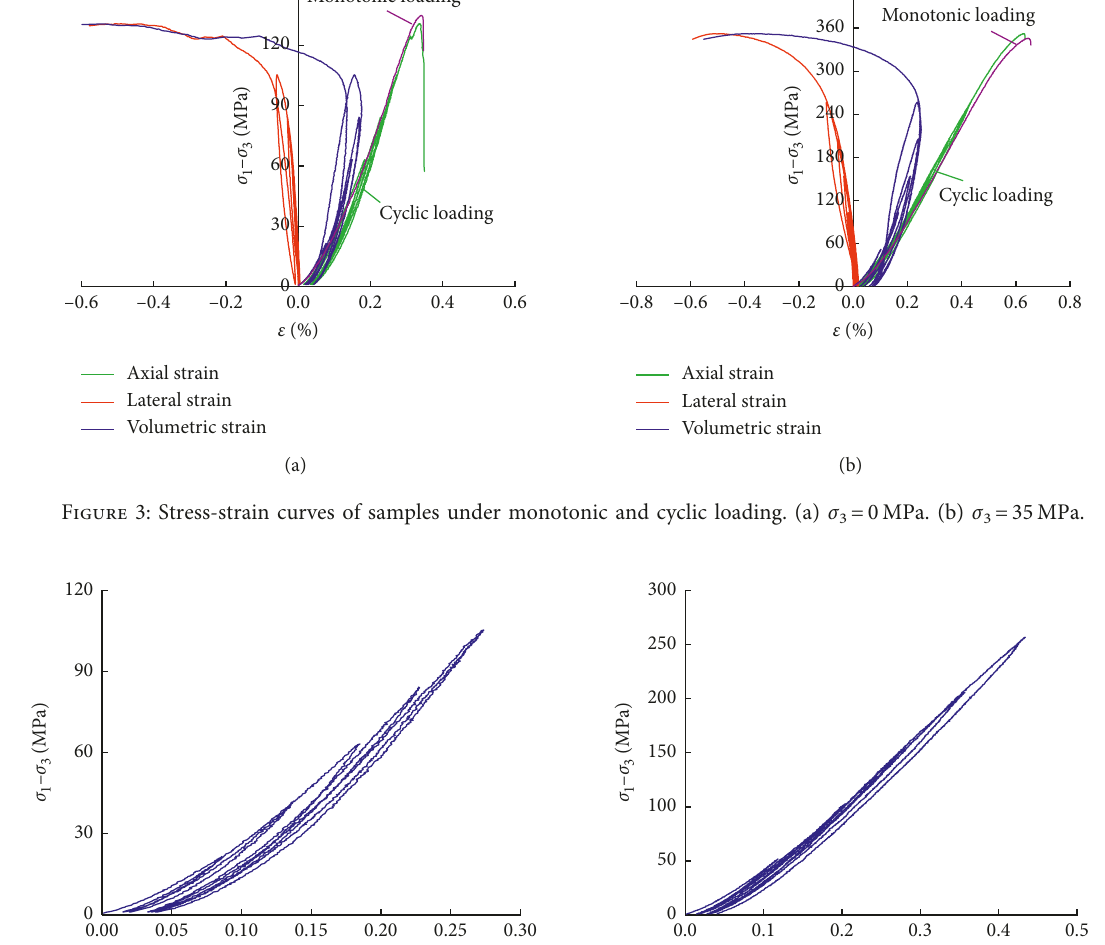
3 (cid:31) 0 MPa. (b) σ 3 (cid:31) 35